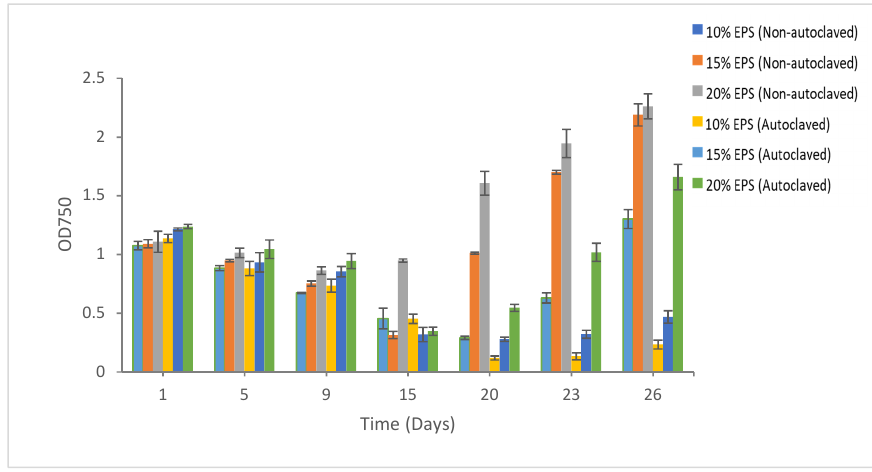
Figure 6. Growth recovery for Synechococcus sp. CB0101 after 9 months of cryopreservation in autoclaved and non-autoclaved EPSs as the cryoprotective agents. Duplicate samples were measured.